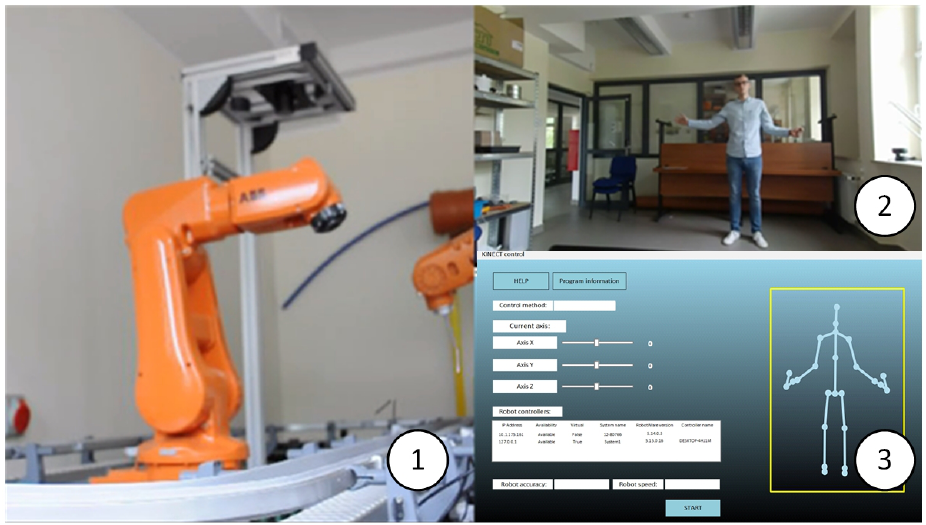
Figure 7. Views of the test station: 1—ABB IRB 120 robot, 2—operator, 3—operator interface